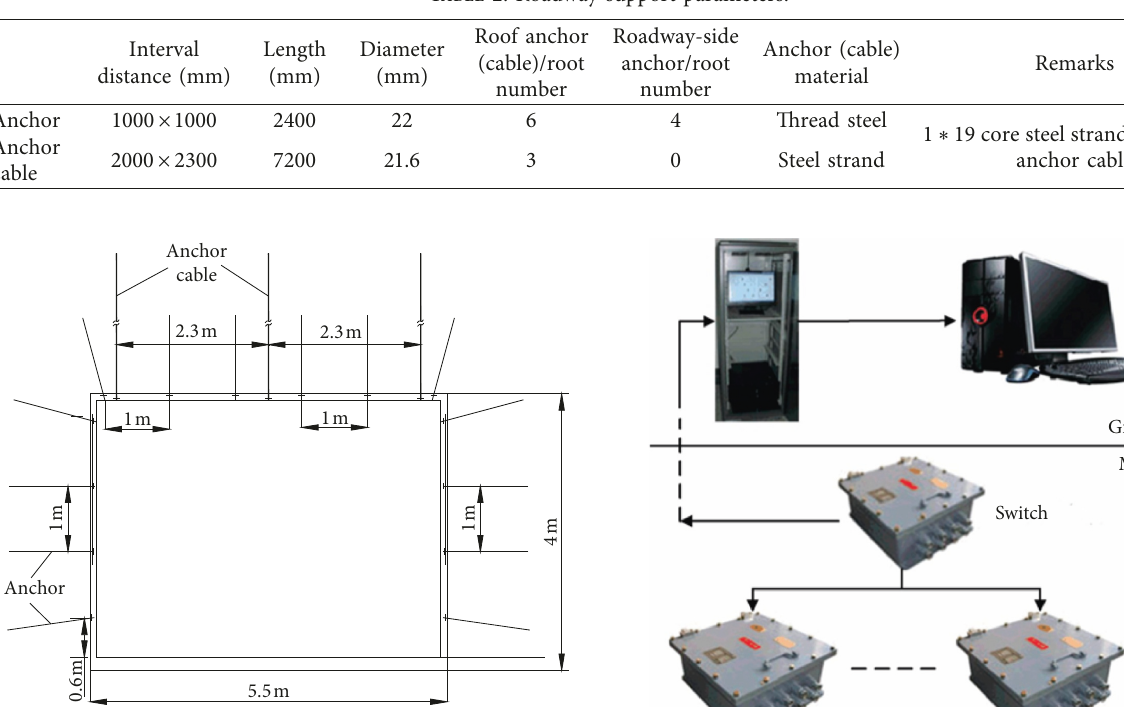
Figure 3: No. 3 coal seam roof and floor lithology. Table 2: Roadway support parameters.